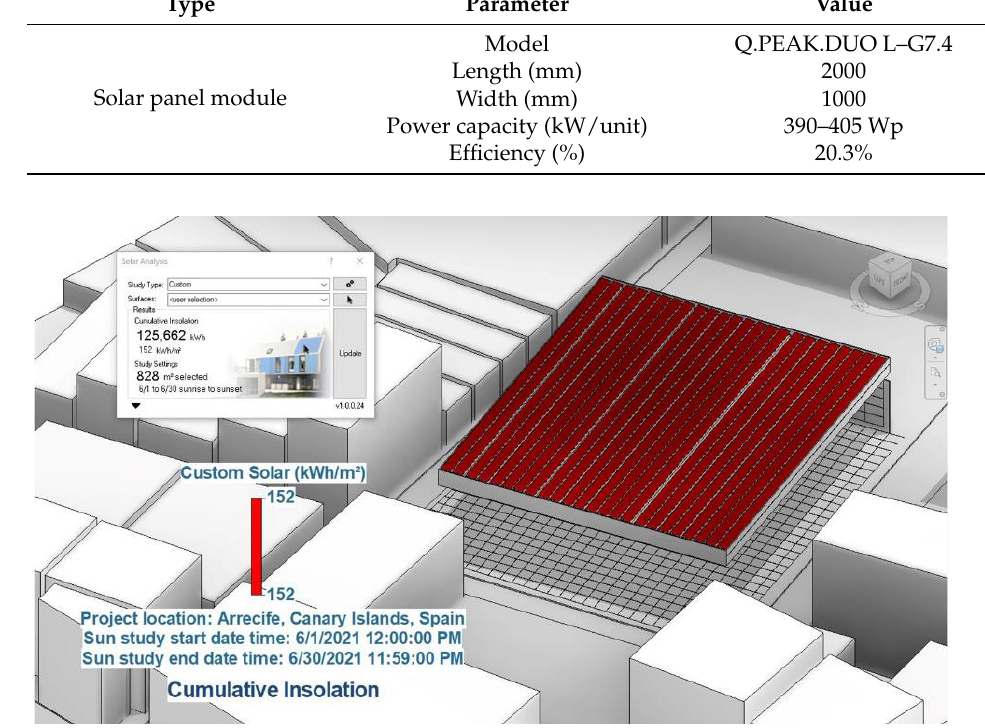
Figure 7. An example of measurement of solar energy generation in June using Revit and plug-in software, Insight.